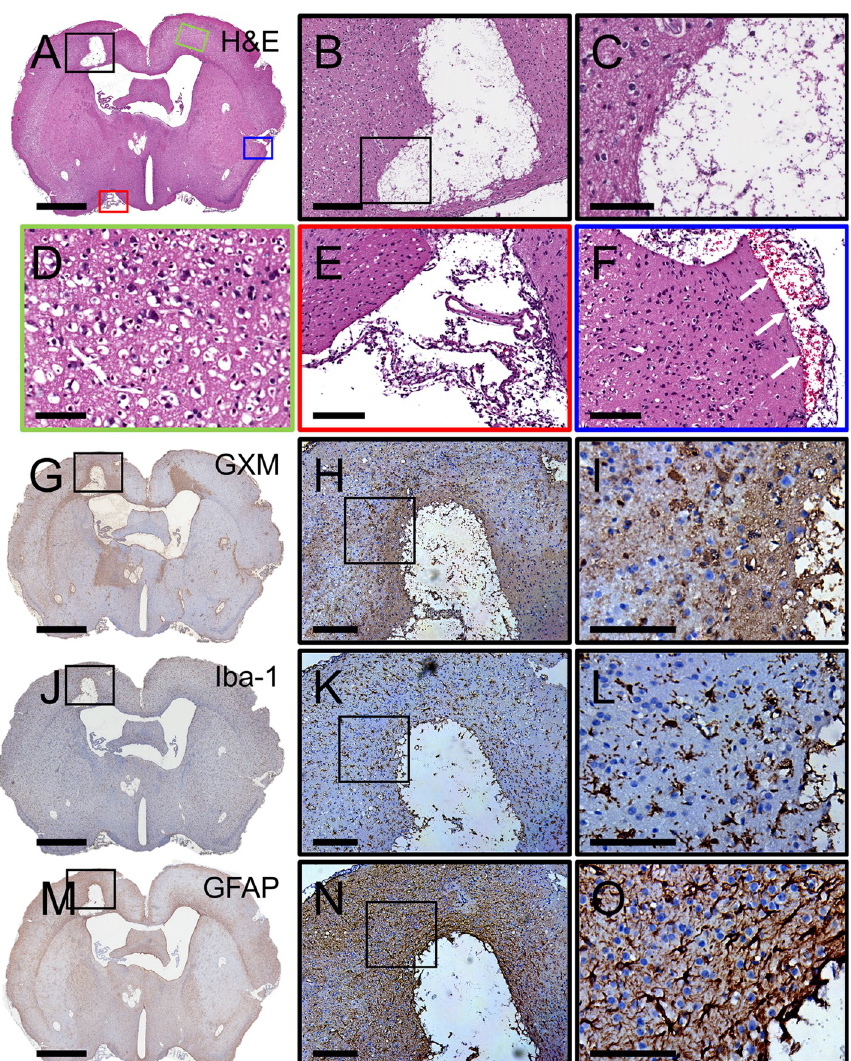
Fig 3. Cerebral cryptococcosis in mice infected in cortical tissue. Representative coronal brain sections (scale bar: 1 mm) of cortical-infected mice stained with (A-C) H&E, (G-I) GXM-specific mAb 18B7, (J-L) Iba-1 (microglia), and (M-O) GFAP (astrocytes) are shown after tissue excision 7-dpi. (D) Green, (E) red, and (F) blue boxes are a magnification (scale bar: 100 μ m) of specific regions of the brain in A . White arrows in F show hemorrhage in the subarachnoid space. Middle ( B , H , K , N ; scale bar: 100 μ m) and right ( C , I , L , O ; scale bar: 20 μ m) panel images are a magnification of the smaller box in the corresponding left-stained section to better show the tissue morphology, GXM distribution (brown stain), and glial cell recruitment/activation (brown stain). Five mice per infection route were evaluated to confirm all the histopathological observations reported in these studies.